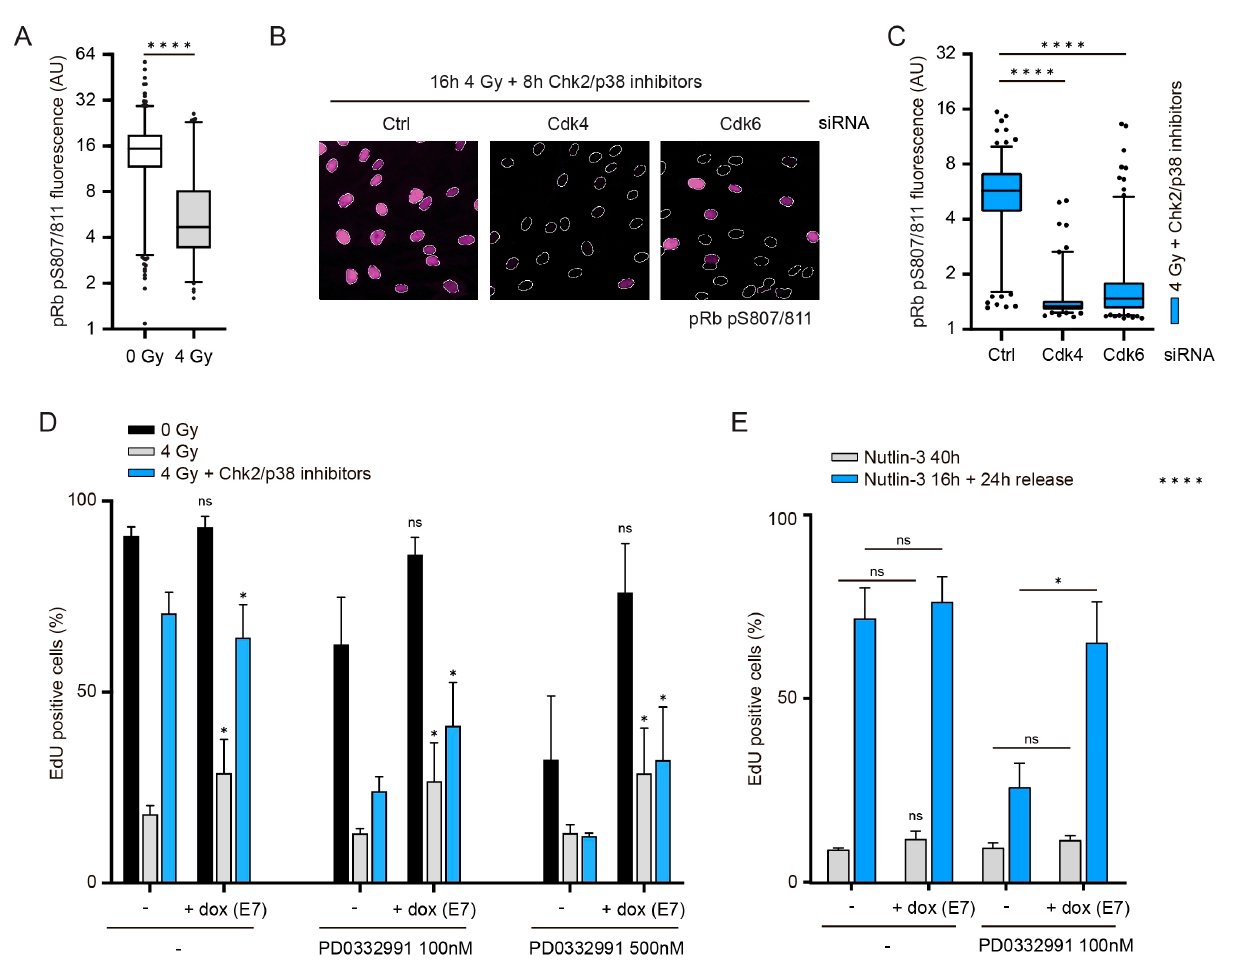
Figure 4. Cdk4/6 are required for more than pocket protein inactivation: ( A ) RPE-1 cells were synchronized in G1 and (mock) irradiated. Cells were fixed 8 h later for immunofluorescent detection of S807/811-phosphorylated pRb. ( B ) RPE-1 cells were transfected with siRNAs during serum starvation and irradiated (4 Gy) in G1. 16 h after irradiation, Chk2 and p38 inhibitors were added and cells were collected 8 h afterwards for immunofluorescent detection of S807/811-phosphorylated pRb. White outlines demarcate nuclei based on DAPI counterstaining. Nuclear fluorescence intensities were quantified in ( C ). At least 100 cells were quantified per condition. ( D ) RPE-E7 cells were synchronized in G1 and mock-treated or irradiated (4 Gy). 16 h after irradiation, doxycycline, PD0332991, and Chk2/p38 inhibitors were added where indicated for additional 24 h. S-phase entry was detected by EdU incorporation. Depicted are the means and SD of three independent experiments. Significance was calculated by comparing cells treated with doxycycline to cells treated without doxycycline, that were otherwise treated the same (e.g., 4 Gy irradiated cells treated with 100 nM PD03329991 and doxycycline were compared to 4 Gy irradiated cells treated with 100 nM PD0332991 without doxycycline). ( E ) Nutlin-3 was added to G1-synchronized RPE-E7 cells for 16 h, when it was either maintained or washed out (release). PD0332991 and doxycycline were added during the release, where indicated. S-phase entry was determined by EdU incorporation. Depicted are the means and SD from 4–6 replicates from two independent experiments. For all panels, significance was calculated using a one-sided unpaired t -test. * p < 0.05, **** p < 0.0001, ns = not